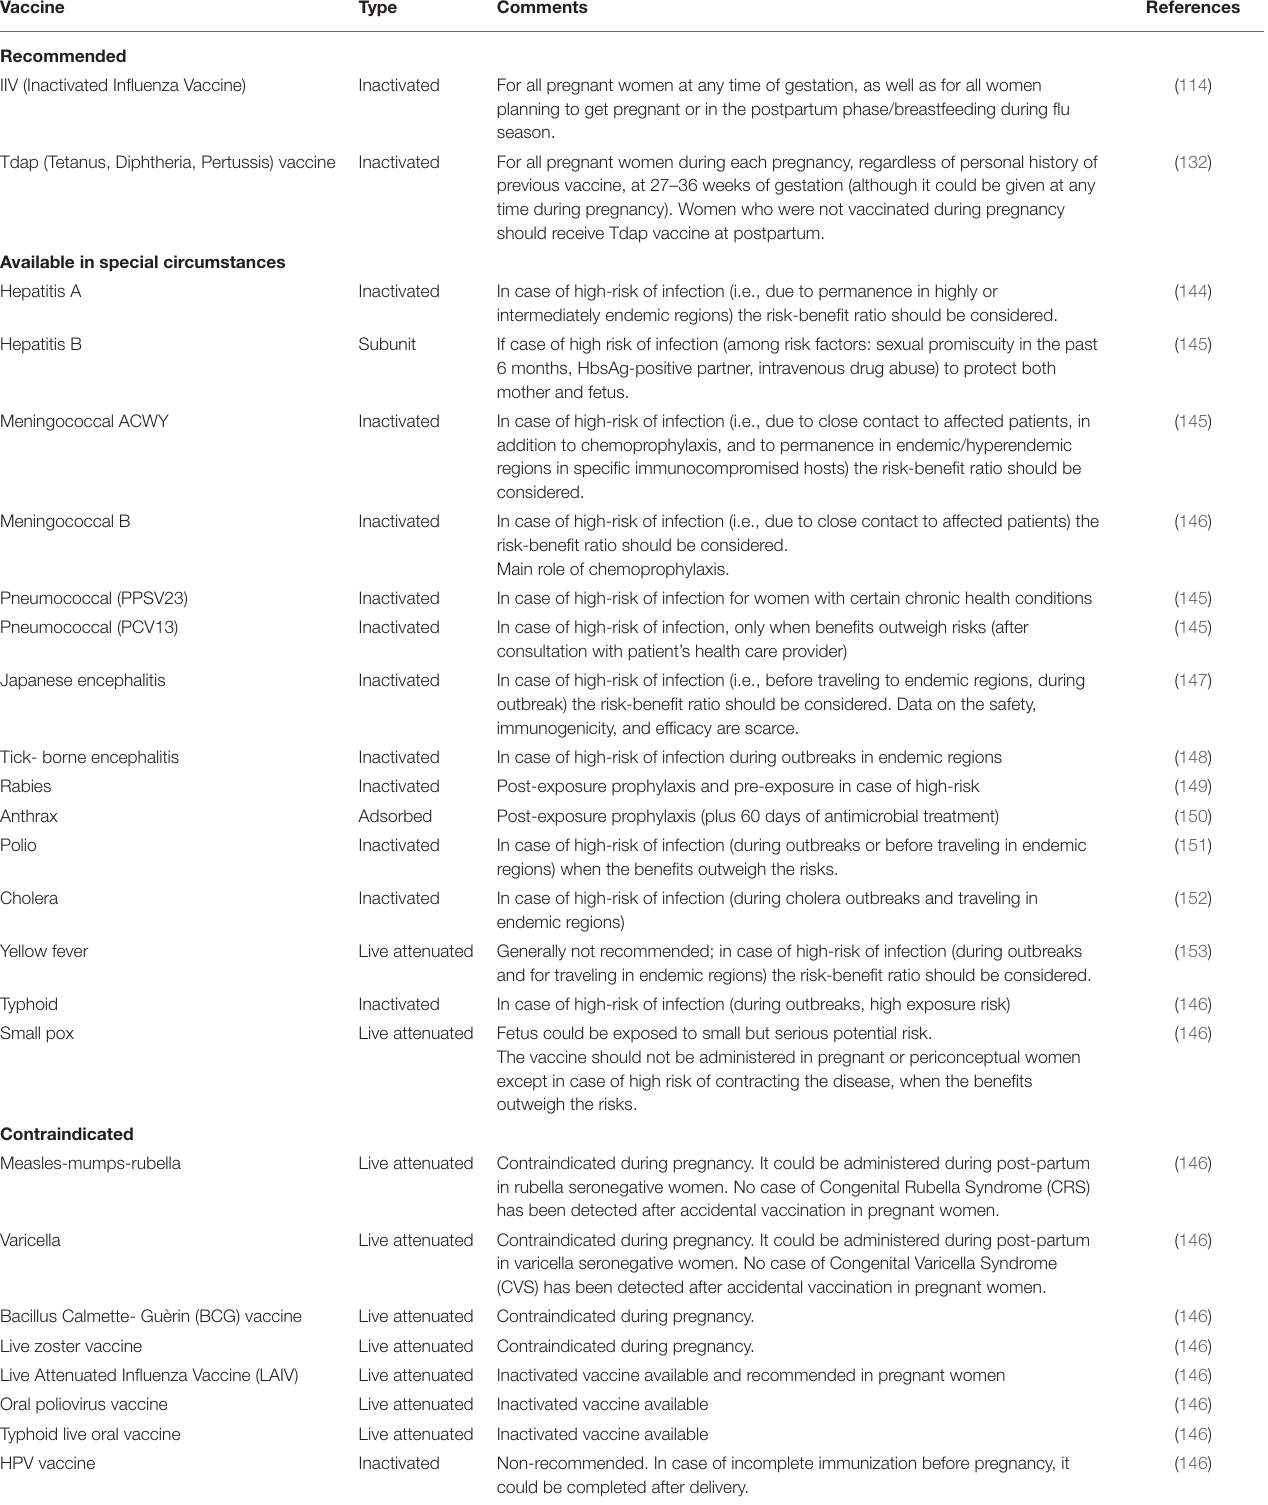
TABLE 1 | Vaccines recommended, contraindicated, and available in special circumstances during